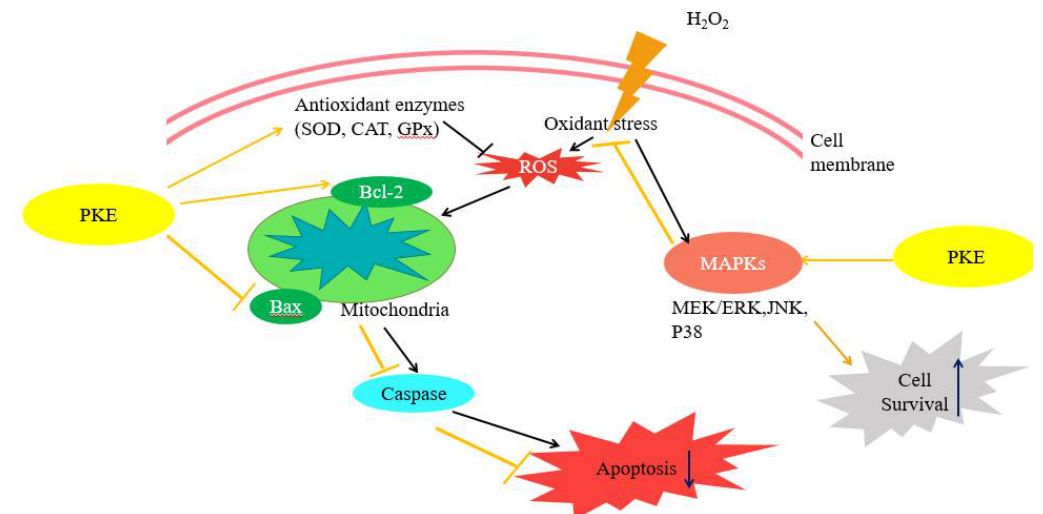
Figure 9. The possible routes by which PKE protects SW1353 from oxidative stress through JNK, MEK/ERK, and p38 pathways.